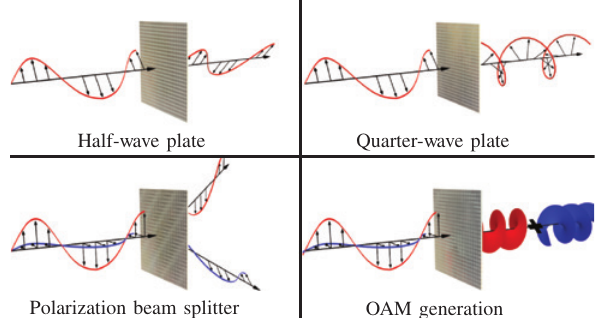
Figure 9: Birefringent metasurface transformations presented in Ref.